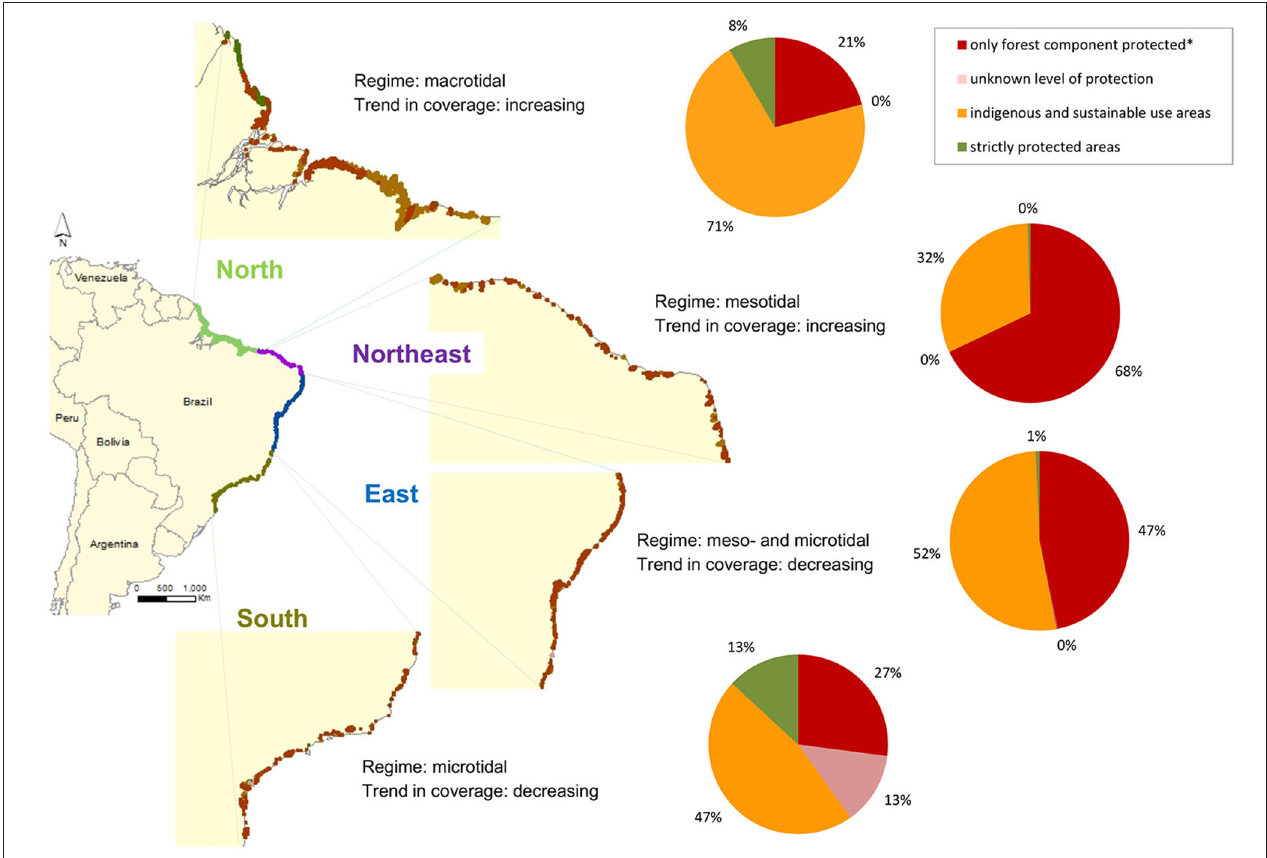
FIGURE 1 | Brazilian mangroves and formal protection level for each proposed macro-unit. Based on Knoppers et al. (1999), Godoy and Lacerda (2015). The mangrove distribution data derive from Giri et al. (2011), and the protected area data from (IUCN UNEP-WCMC., 2017). “Unknown protection” was assigned to categories whose level of protection was not declared in the UNEP-WCMC dataset. *“only forest component protected” refers to mangrove areas that are not inside a protected area or indigenous area, but are, like all forest components of mangroves in Brazil, protected under the Forest Code (BRASIL, 2012) as “permanent protection areas.” Considering the states in Brazil, the division goes as follows: AP, PA, and MA (North); PI, CE, and RN (Northeast); PB, PE, AL, SE, and BA (East); ES, RJ, SP, PR, and SC (Southeast).